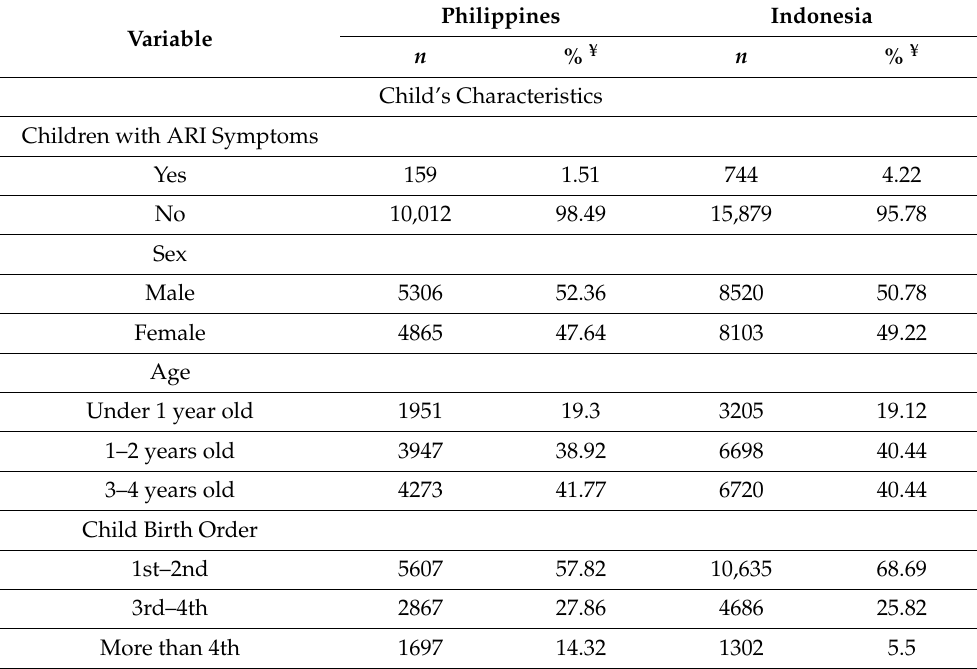
Table 1. Socio-demographic characteristics of participants in the Philippines and Indonesia in